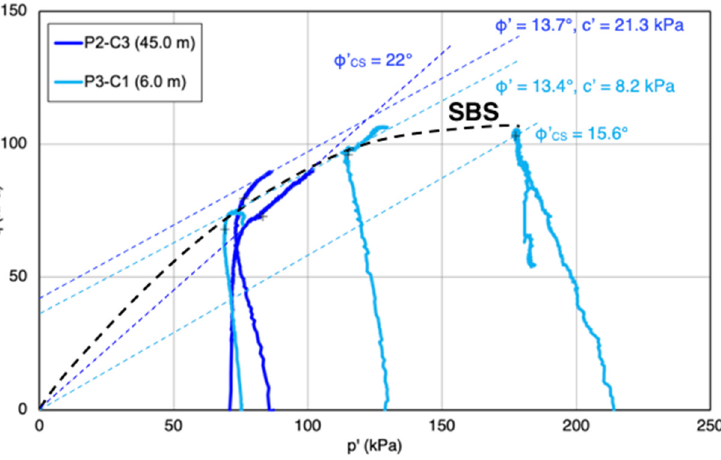
Figure 19. CIU triaxial stress-paths for deep clayey Faeto Flysch (borehole P2-C3, 45 m b.g.l.) and shallow altered cover of the same formation (P3-C1, 6 m b.g.l.) at Bovino.